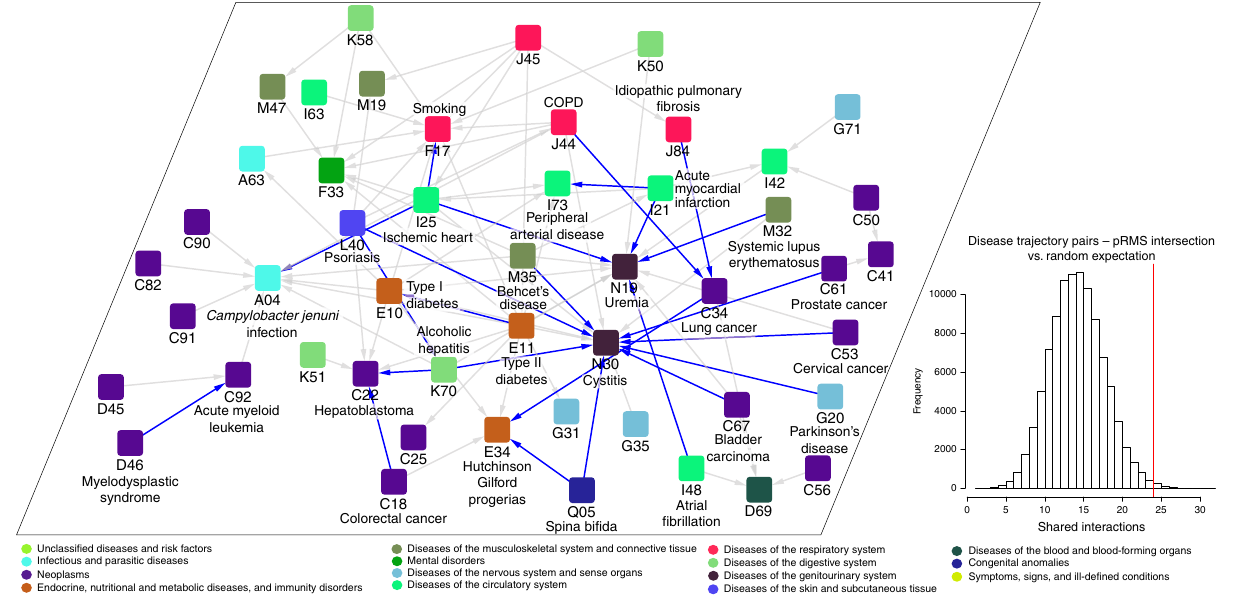
Fig. 4 Epidemiologically described disease comorbidities present in the Disease Molecular Similarity Network. Disease-pairs extracted from the Temporal disease trajectories (gray edges) showing which pairs are also detected in the transcriptomic-based comorbidity relations identi fi ed by our approach (blue edges). Since the ICD10 codes might involve several diseases, we indicate the speci fi c names of the diseases we are analyzing using transcriptomic data involved in pRMS interactions. Inset: The overlap is statistically higher than what would be expected from randomized datasets (see “ Methods ”